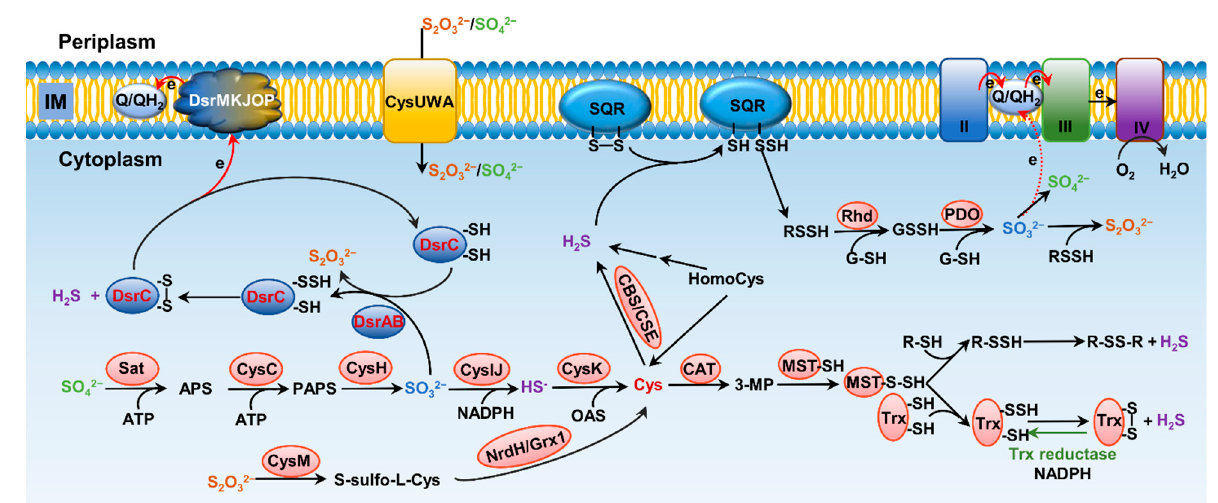
Figure 2. Pathways for bacterial sulfur metabolism in the cytoplasm. H 2 S biogenesis through amino acid metabolism: generation of H 2 S from homocys can be catalyzed by cystathionine β -synthase (CBS) and cystathionine γ -lyase (CSE). Cys aminotransferase (CAT) catalyzes the formation of 3- mercaptopyruvate (3-MP) from cys, and then, mercaptopyruvate sulfurtransferase (MST) converts 3-MP to H 2 S. H 2 S biogenesis occurs through assimilatory sulfate reduction (ASR) and dissimilatory sulfate reduction (DSR) of inorganic sulfur species; the latter only occurs in sulfate-reducing bacteria (SRB), catalyzing SO 32 − to HS − through dissimilatory sulfite reductase (Dsr). For ASR pathway, SO 42 − , which imported from ATP-dependent transporter CysUWA, is catalyzed and converted to HS − by a series of enzymes, including Sat, CysC, CysH, and CysIJ. S 2 O 32 − can also be reduced and used to synthesize cys by CysM and NrdH/Grx1. H 2 S catabolism: H 2 S binds to sulfur quinone oxidoreductase (SQR), and goes through a series of sequential reactions, including oxidation of sulfide to polysulfide by membrane-bound SQR, formation of GSSH from reaction involving with rhodanese (Rhd), oxidation of the sulfane sulfur in GSSH to SO 32 − catalyzed by persulfide dioxygenase (PDO), formation of S 2 O 32 − from spontaneous reaction between polysulfide and SO 32 − , and formation of SO 42 − either spontaneously or catalyzed by various enzymes, transferring two electrons via quinone into the electron transport chain.